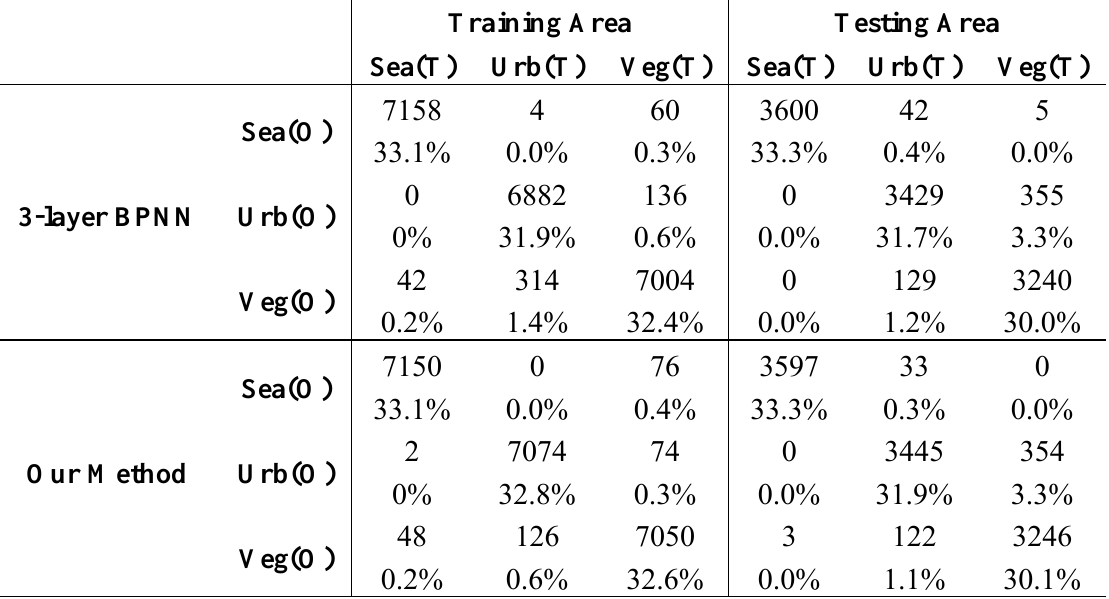
Table 4. Comparison of confusion matrix.(O denotes the output class, T denotes the target class).